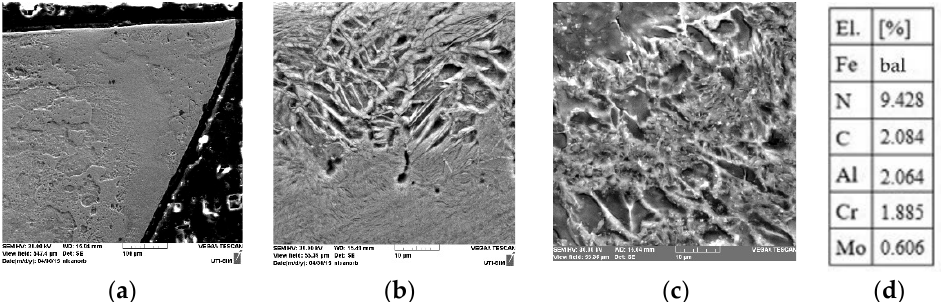
Figure 9. Active screen nitrided sample SEM micrographs, 60° area B, different scale: ( a ) 100 µm, ( b ) 10 µm, ( c ) 10 µm, and ( d ) mass concentration of elements per area.